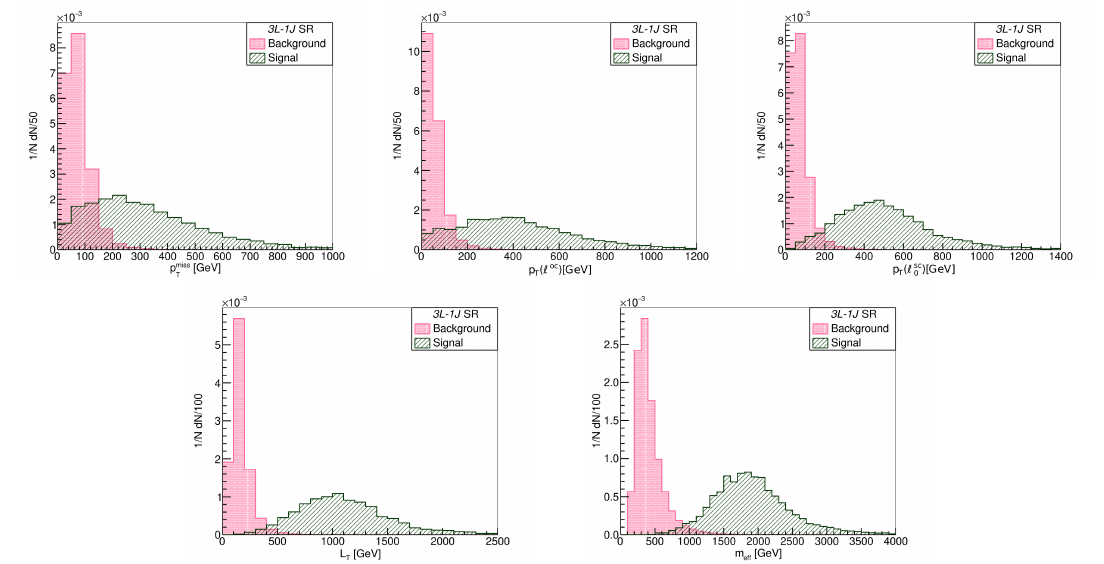
Figure 5 . Normalised kinematic distributions for 3L-1J events for BP1 : M χ = 1 TeV and BR ( χ ± → νW ± ) ≈ 50% in Model- 3 F (middle) and p of the leading same-charge lepton (right); bottom panel: L T